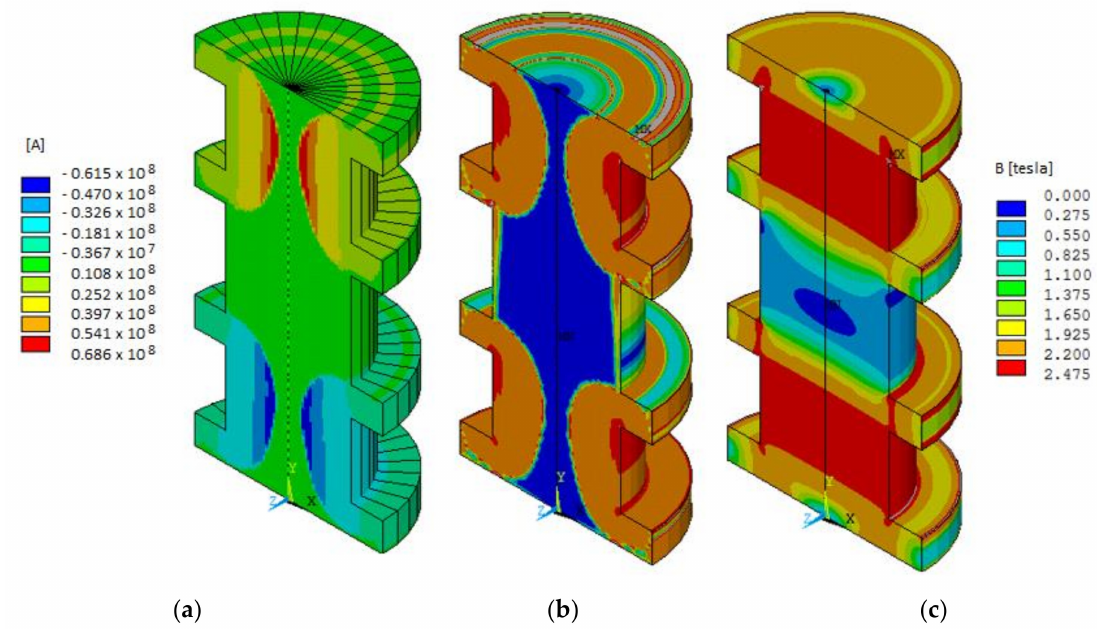
Figure 24. Eddy current analysis—( a ) eddy current density; ( b ) value of magnetic induction in the core for analysis considering eddy currents; ( c ) value of magnetic induction in the core for analysis excluding eddy